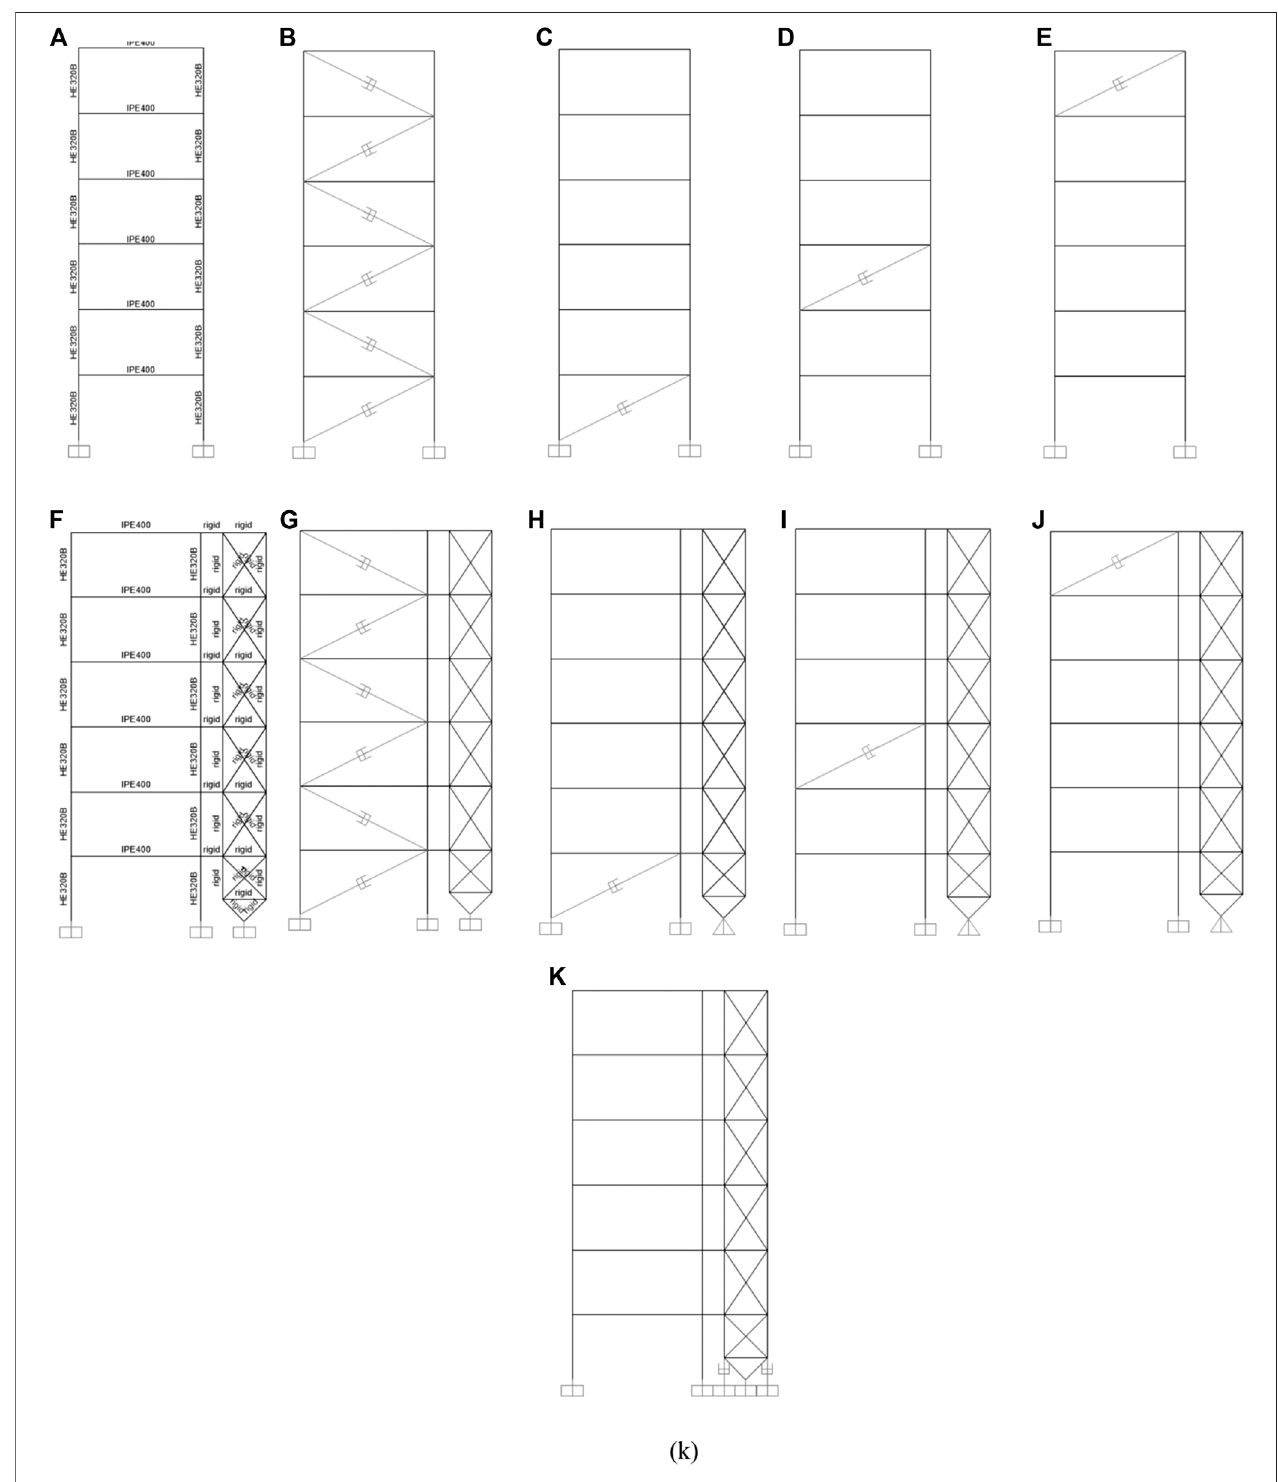
FIGURE5|(A) BF-NAKEDmodel; (B) BF-SPDmodel; (C) BF-IS1model; (D) BF-IS3model; (E) BF-IS6model; (F) SB-NAKEDmodel; (G) SB-SPDmodel; (H) SB- IS1 model; (I) SB-IS3 model; (J) SB-IS6 model; (K) SB-DT model.